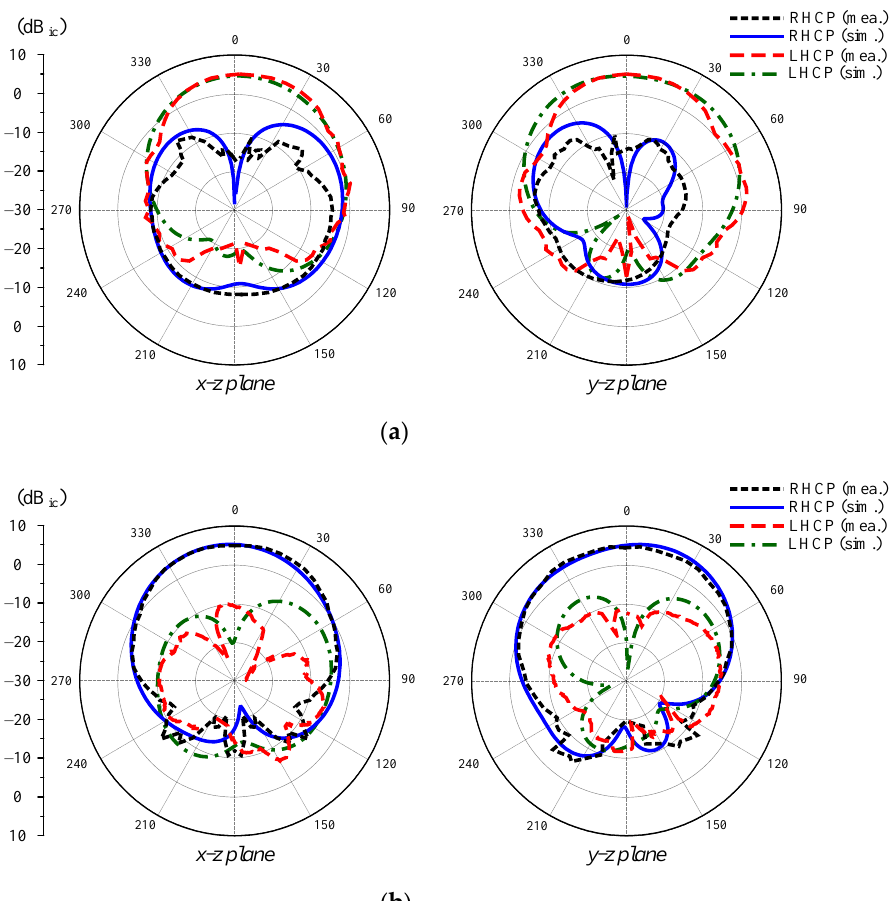
Figure 14. Simulated and measured radiation patterns of the proposed MIMO CP antenna. ( a ) 5.2 GHz with Port-1 excitation, ( b ) 5.4 GHz with Port-2 excitation.